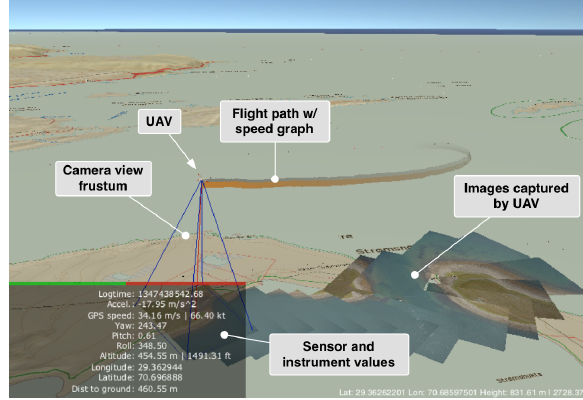
Figure 1: Screenshot from Norut Geo Viz, visualizing a flight conducted near Berlev˚ag, Norway in